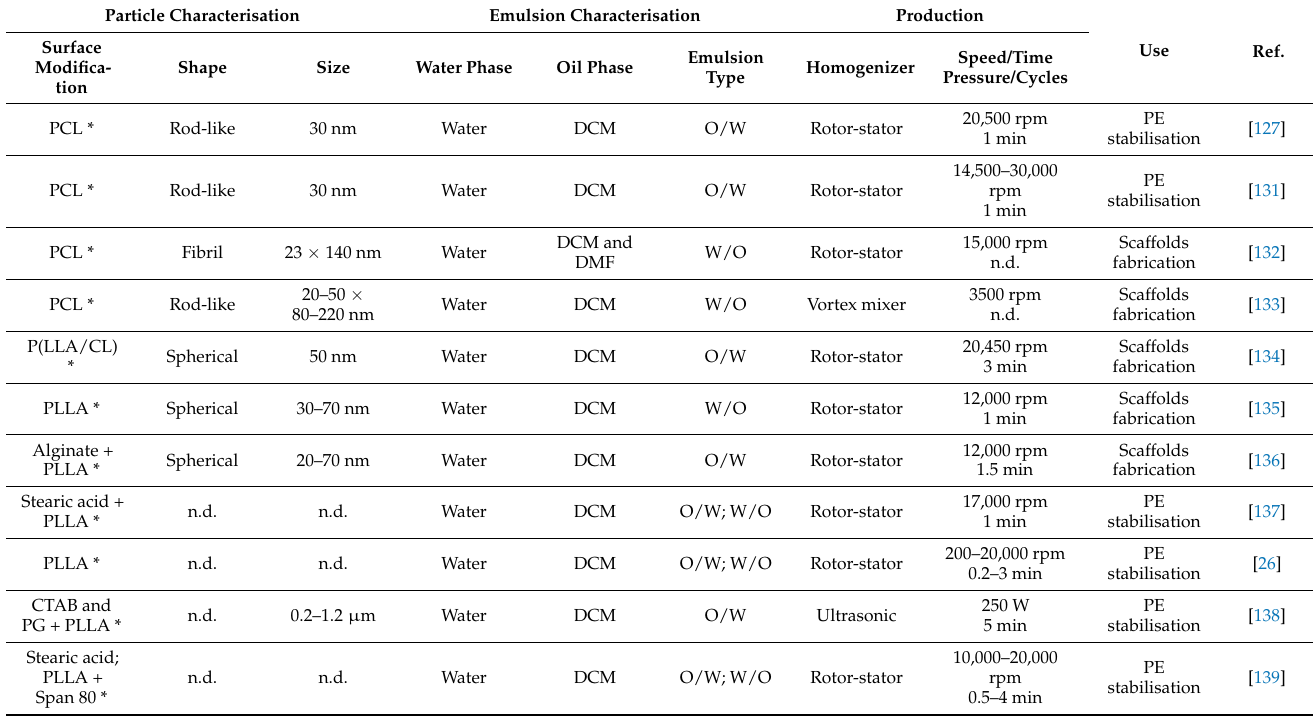
Table 2. Main PEs produced with HAp as solid